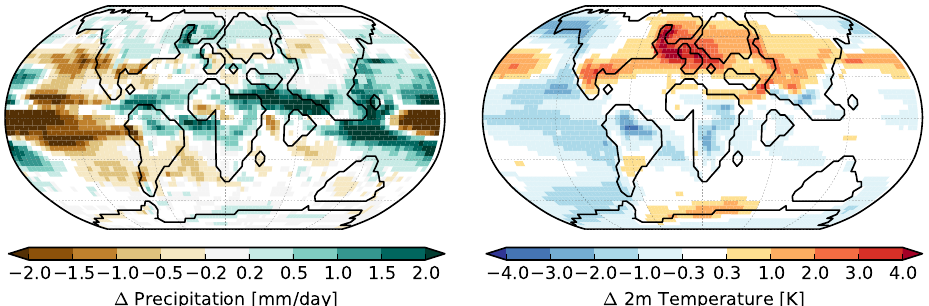
Figure 6. Differences in precipitation and 2m temperature between the FE d simulation and the DE d simulation. The average over the last 30 years of the simulations is considered. Depicted differences are significant on a 95% level.